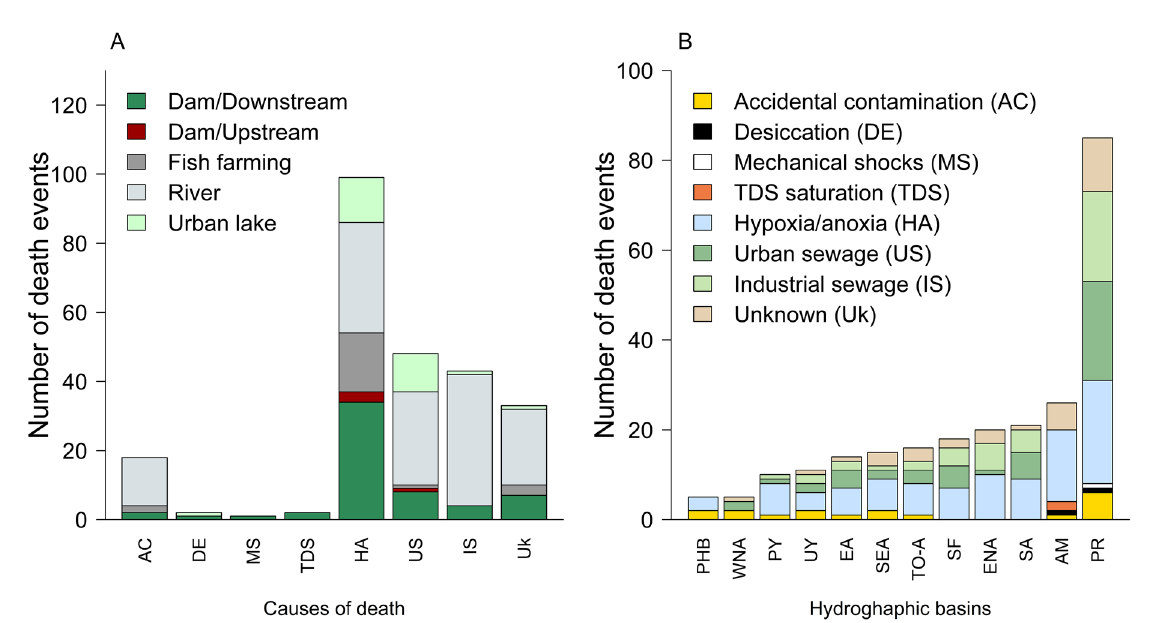
FIGURE 6 | ( A ) Number of fish mortality events at different sites, considering the cause of death and ( B ) Number of fish mortality events at different sites, by cause of death attributed considering the Brazilian hydrographic basins. PHB = Parnaiba, WNA = Western Northeast Atlantic, PY = Paraguay, UY = Uruguay, EA = East Atlantic, SEA = Southeast Atlantic, TO-A = Tocantins-Araguaia Basin, SF = San Francisco, ENA = Eastern Northeast Atlantic, SA = Southeast Atlantic, AM = Amazon, PR = Paraná. See codes for causes of death in Tab.